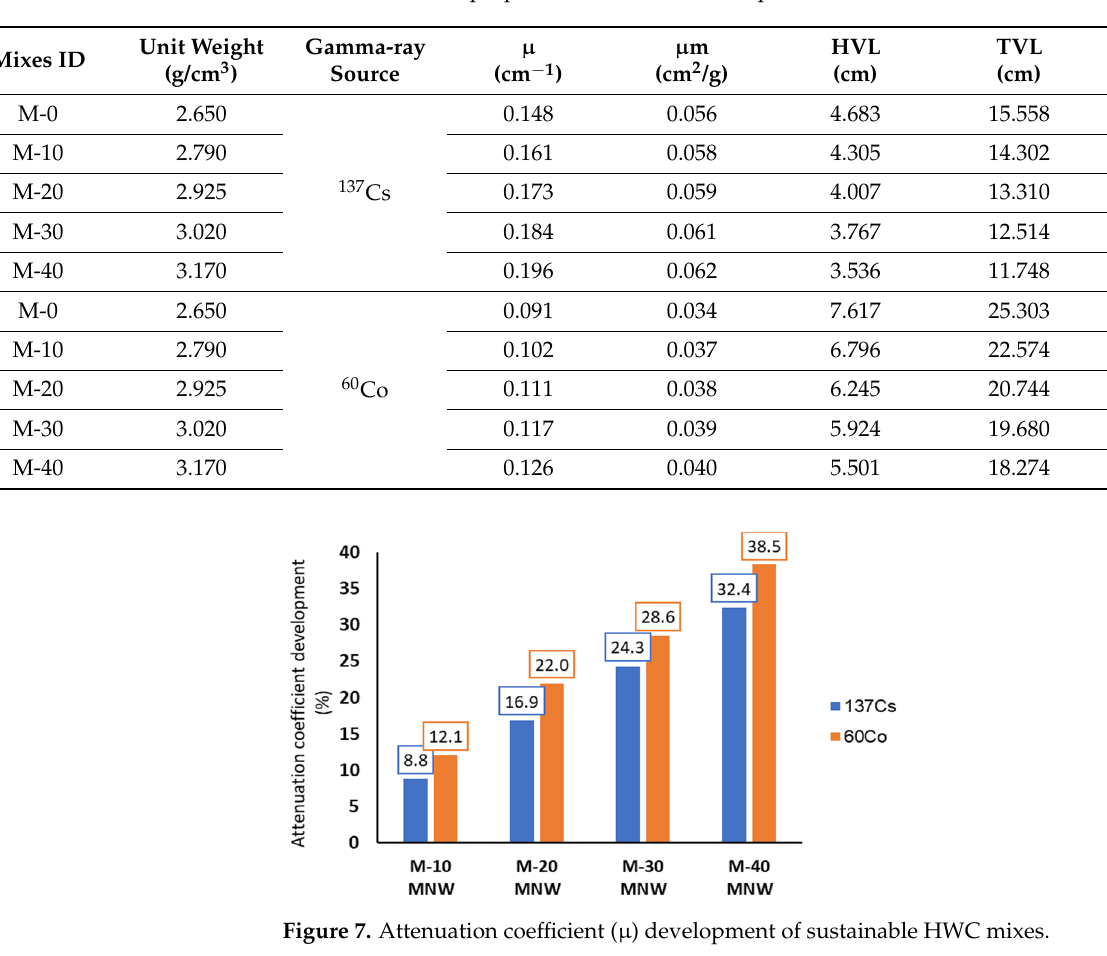
Table 3. Radiation properties of HWC mixtures produced with MNW.